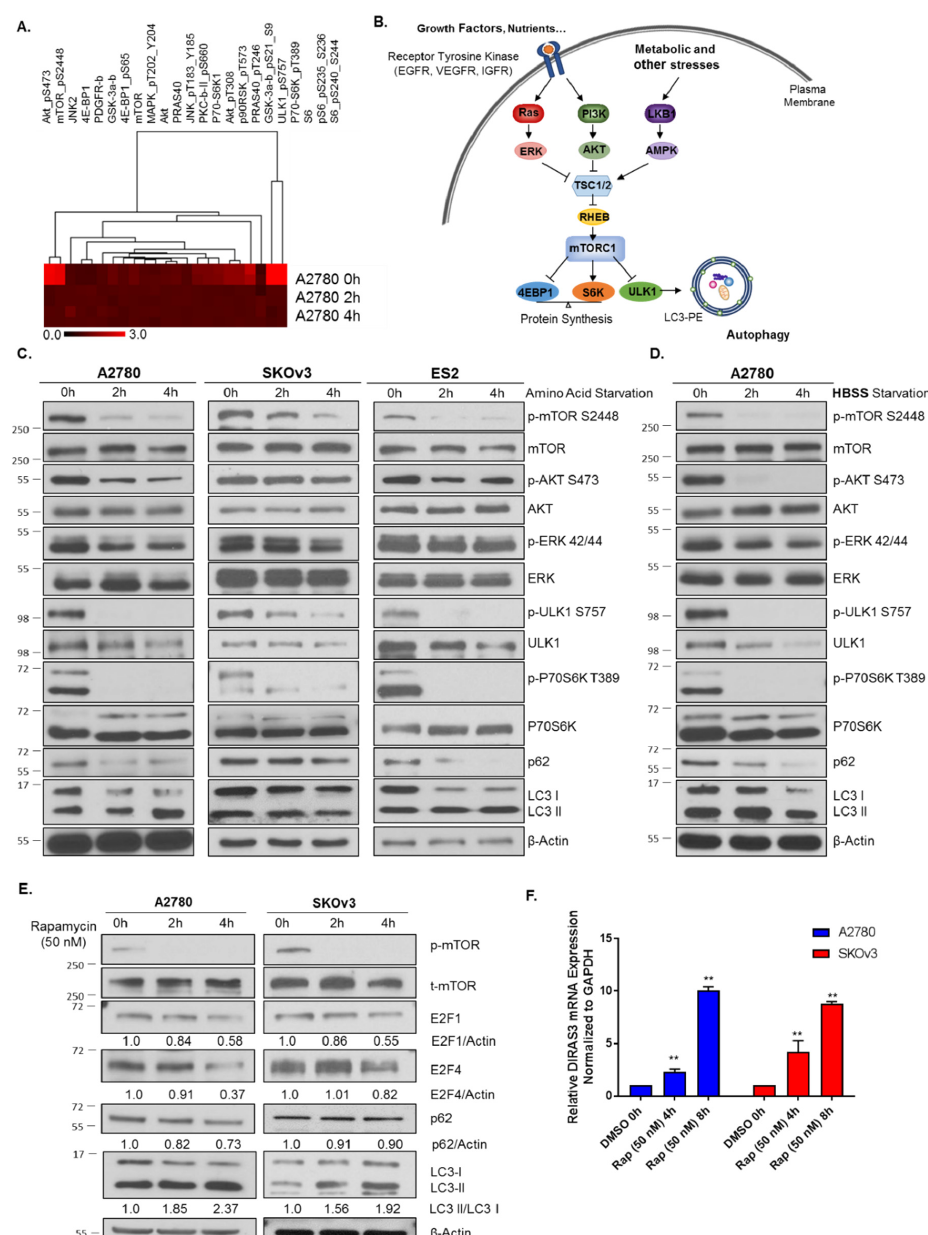
Figure 2. Nutrient deprivation leads to mTOR inhibition and activation of autophagy. ( A ) Reverse phase protein lysate arrays were performed following amino acid deprivation in A2780 cells for 2–4 h, in duplicate. A heat map was generated based on the fold change observed compared to unstarved cells. ( B ) Model depiction of key signaling pathways activated upon nutrient deprivation which can lead to autophagy induction. ( C ) Western blot analysis following amino acid starvation in A2780, SKOv3 and ES2 cells for 0–4 h. Blots were probed as indicated documenting a decrease in mTOR signaling, and induction of autophagy. ( D ) Western blot analysis following treatment of A270 ovarian cancer cells with HBSS supplemented with 3% Glucose for 0–4 h. Blots were probed as indicated and confirmed similar signaling and induction of autophagy as determined by RPPA analysis. ( E ) A2780 and SKOv3 ovarian cancer cells were treated with 50 nM Rapamycin for 0–4 h and western blot analysis performed. Blots were probed as indicated and decreases were observed in p-mTOR, E2F1 and E2F4 as well as the induction of autophagy. ( F ) qRT-PCR analysis following rapamycin (50 nM) treatment for 0–4 h. mRNA expression of DIRAS3 as compared to GAPDH was determined. Bars indicate the mean ± standard deviation. Experiments were performed in triplicate. ** p < 0.01. Raw data films for western blot analysis shown in Figure